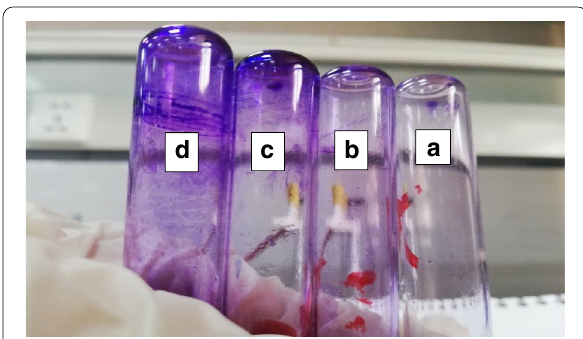
Fig. 2 Violet color developed by some Streptococcus mutans isolates showing different degrees of their formed biofilms as determined